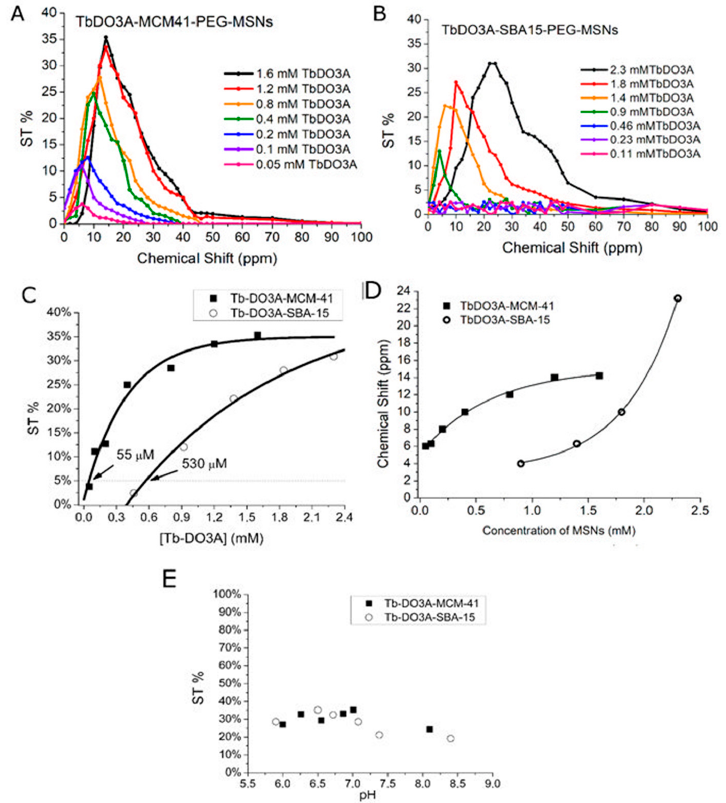
Figure 4. ST% of ( A ) TbDO3A-MCM-41 and of ( B ) TbDO3A-SBA-15. ( C ) ST% of variable of TbDO3A-MCM-41 (- (cid:4) -) and TbDO3A-SBA-15 (- concentrations of TbDO3A-MCM-41 (- ■ -) and TbDO3A-SBA-15 (- ○ -) MSNs. ( D ) Chemical shift of concentrations of TbDO3A-MCM-41 (- (cid:4) -) and TbDO3A-SBA-15 (- variable concentrations of TbDO3A-MCM-41 (- ■ -) and TbDO3A-SBA-15 (- ○ -) MSNs. ( E ) ST% of values of TbDO3A-MCM-41 (- (cid:4) -) and TbDO3A-SBA-15 (- variable pH values of TbDO3A-MCM-41 (- ■ -) and TbDO3A-SBA-15 (- ○ -) MSNs.